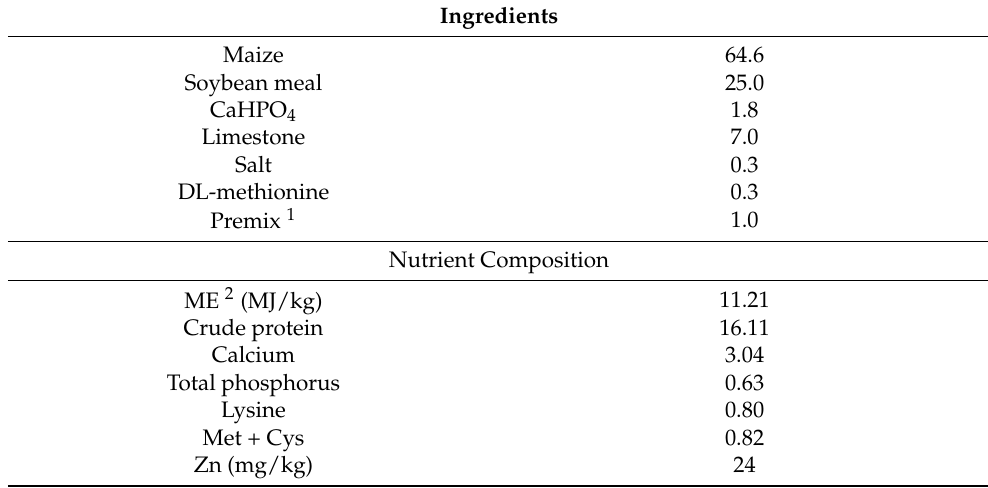
Figure 1. Experimental design of broilers. Table 1. Composition and nutrient level of the basal diet for broiler breeders (%, unless otherwise stated).